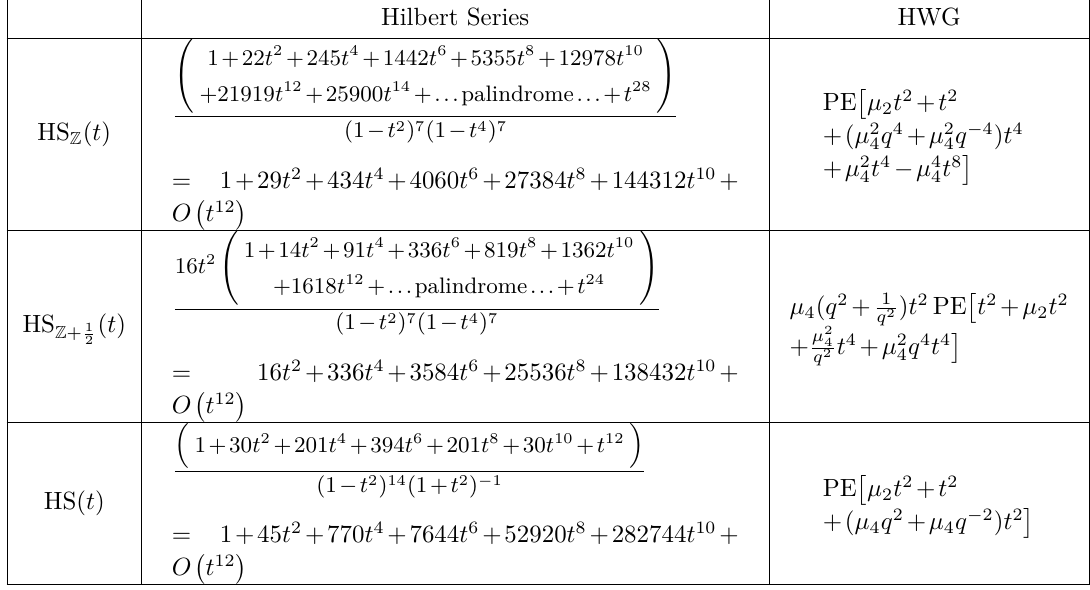
Table 10. Hilbert series for the E 5 magnetic quiver (3.6). The first line of the table provides the Hilbert series when the GNO magnetic lattice is integer HS Z ( t ) , the second line shows the sum over the integers-plus-half lattice HS Z ( t ) and the last line is their sum HS( t ) . In the third + 1 2 column, we show the HWG in terms of fugacities for so (8) (denoted µ 1 , . . . , µ 4 ) and u (1) (denoted q ). Note that the q -charge is normalized, such that the branching of so (10) → so (8) × u (1) is ( µ 5 ) 7→ q +1 ( µ 1 ) + q − 1 ( µ 3 ) . so (10) so (8) so (8)